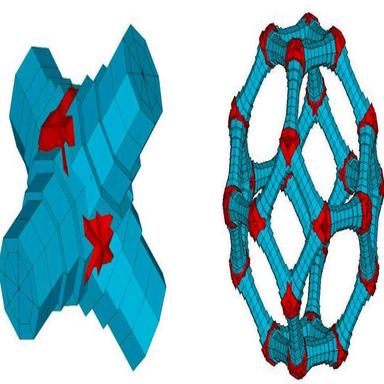
Young's Modulus increment for the ligament segment adjacent to the connection node.